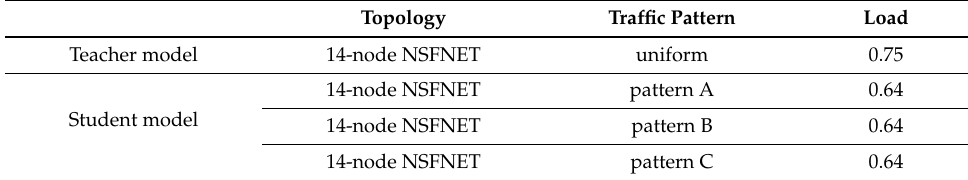
Figure 4. ( a , c , e ): The non-uniform traffic patterns for the student models. ( b , d , f ): Blocking probabili- ties under different traffic patterns (( b ) pattern A, ( d ) pattern B, and ( f ) pattern C) for student model with policy distillation, student model without policy distillation, and the baseline KSP-FF algorithm. Table 3. Traffic loads for all traffic patterns in Section